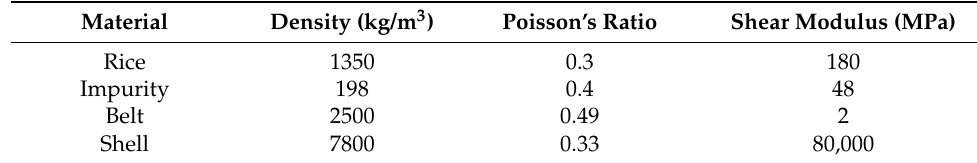
Table 1. Properties of materials used in EDEM.